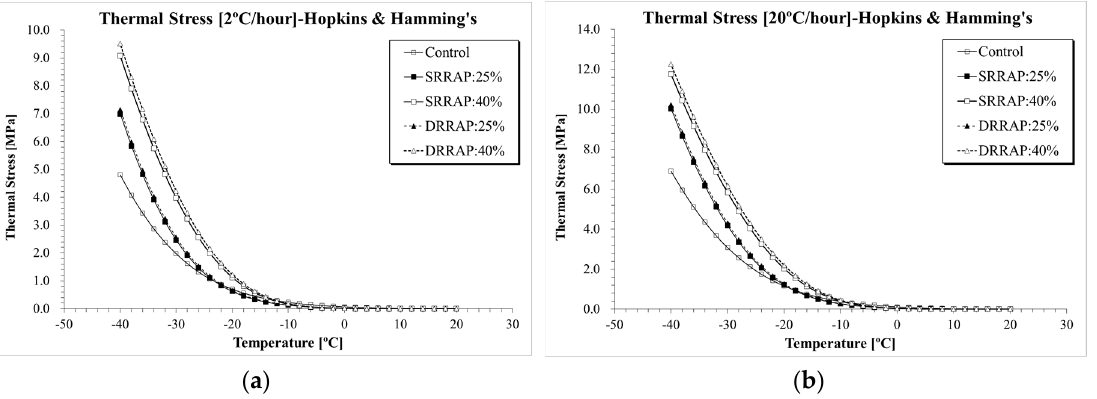
◦ C / h; ( b ) 20 ◦ C / h. Materials 2020 , 13 , x FOR PEER REVIEW